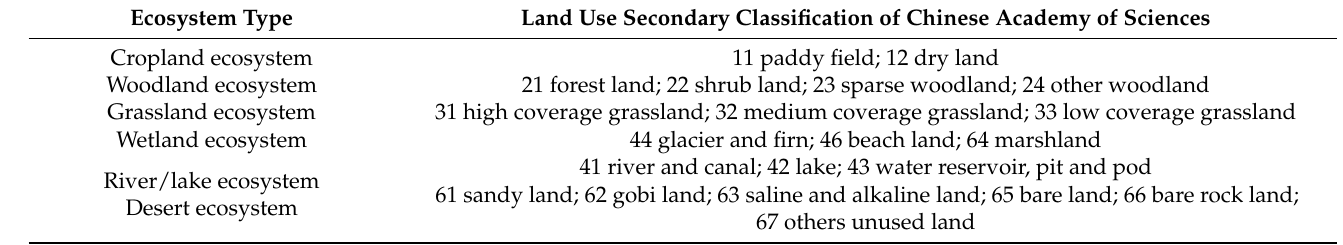
Table 3. The corresponding relationship between ecosystem and land use